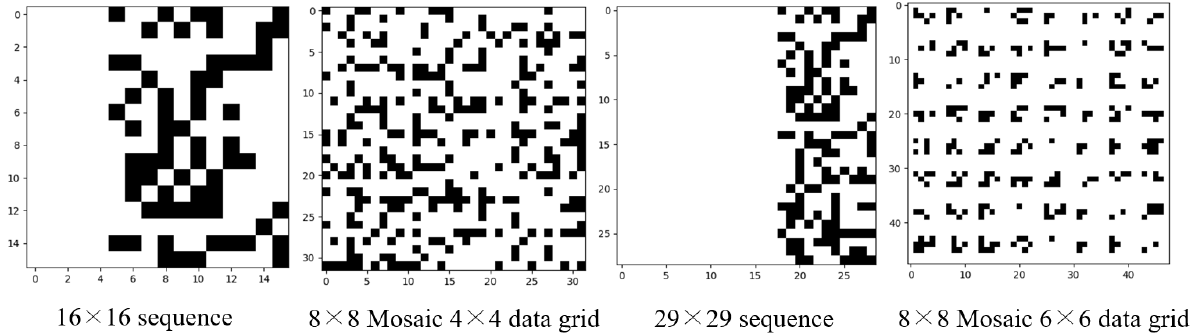
Figure 6. Grid data image, containing Fuzzy attack.